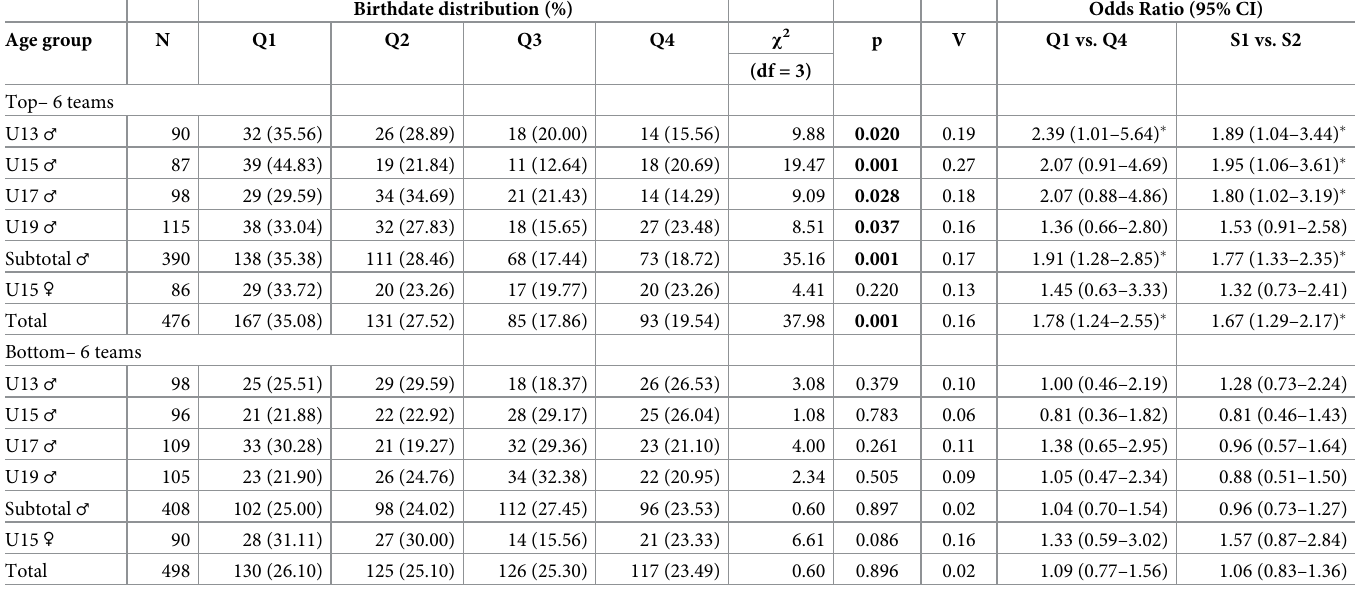
the U7 group that indicated a small effect size. Top teams revealed significantly higher RAEs when compared to bottom tier clubs indicating an effect of competitive level. This was further supported by the large RAE in the Luxembourgish national teams. These findings suggest that the ‘open-door’ policy in Luxembourgish football associated with less strict selection criteria Table 4. Relative age effect analyses of the top-6 and bottom-6